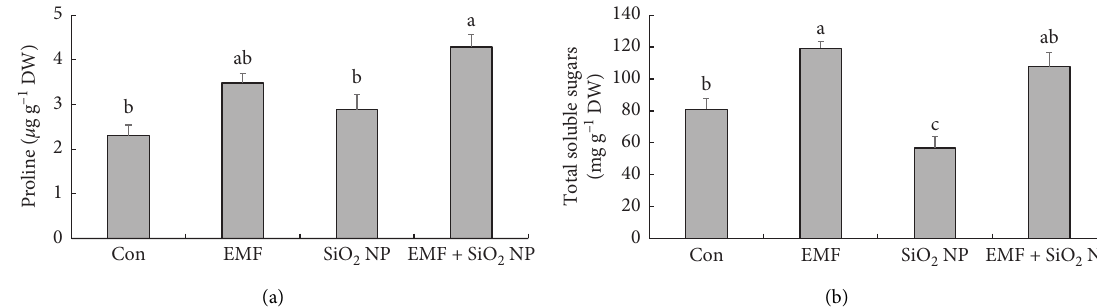
Figure 3: Effect of EMF and SiO 2 NP treatments on the content of proline (a) and total soluble sugars (b) of A. gilanica plants. Bars indicate means ± SE ( n � 3) in each group. Different letters indicate significant differences at P ≤ 0 .